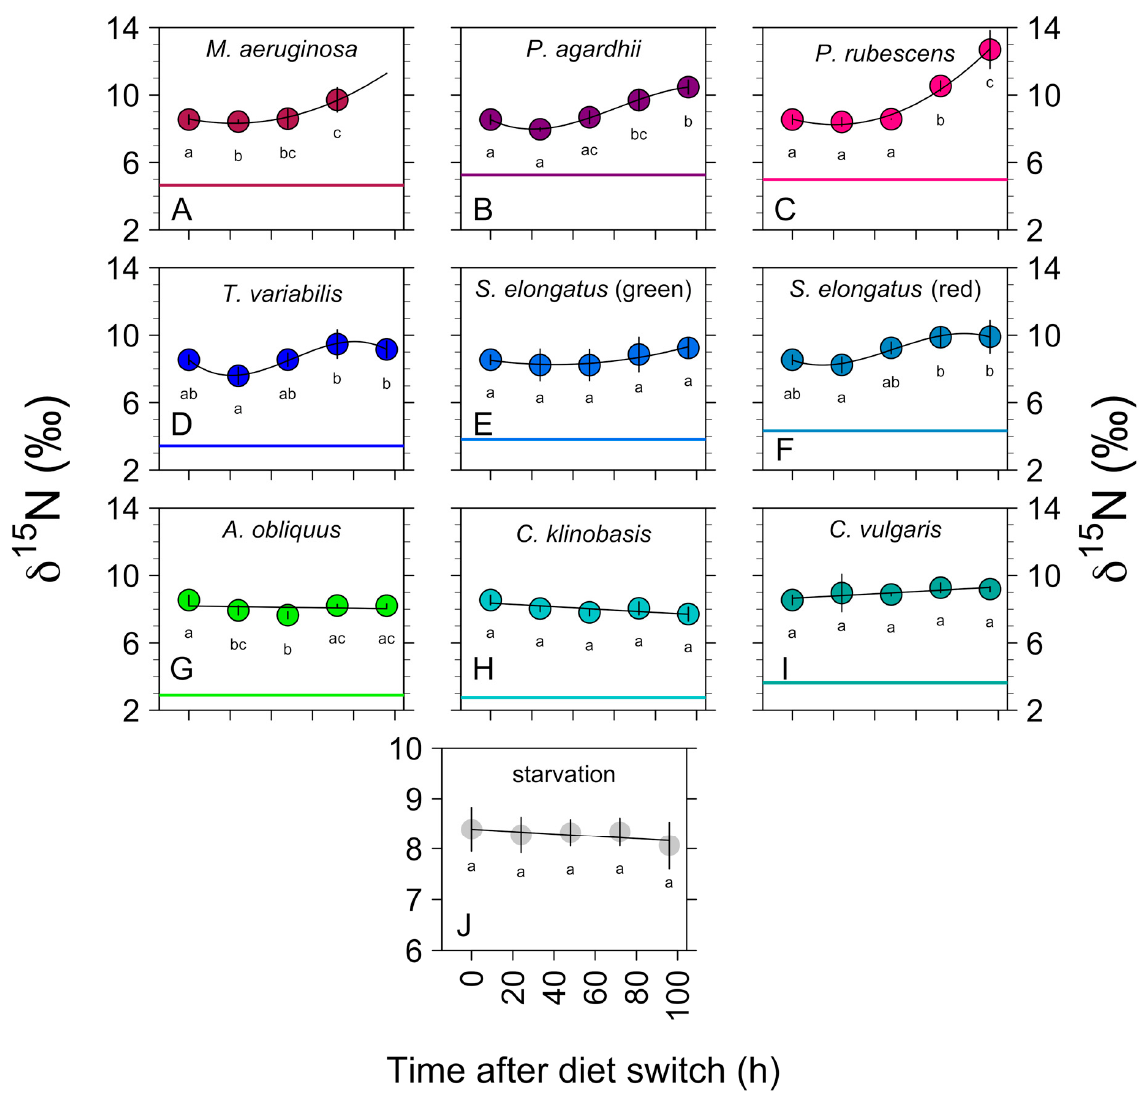
Figure 3. Nitrogen isotopic changes in D. magna tissue shown as a function of time (hours) after changes to the isotopically distinct captive diet types (or during starvation). The colored lines represent the signatures of the associated diets while the black lines represent the polynomial trendlines ( A – F ) or linear trendlines ( G – J ). The letters represent statistical differences for the δ 15 N values of the different timepoints.